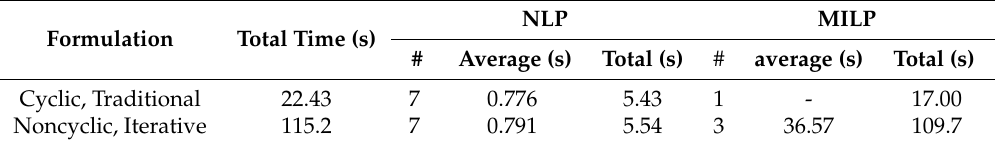
Table 15. Computational results: Scenario 2.